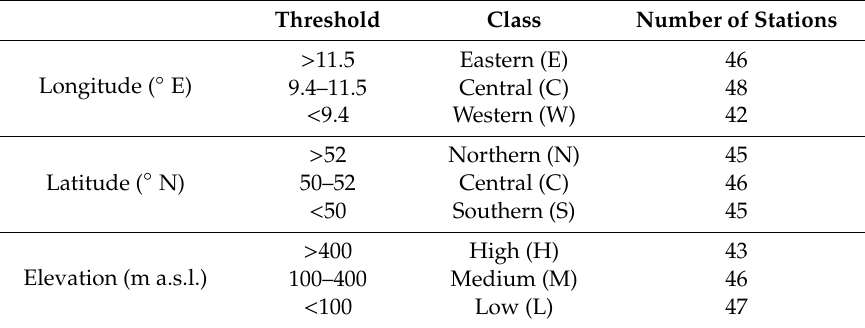
Table 1. Stations by geographical location and